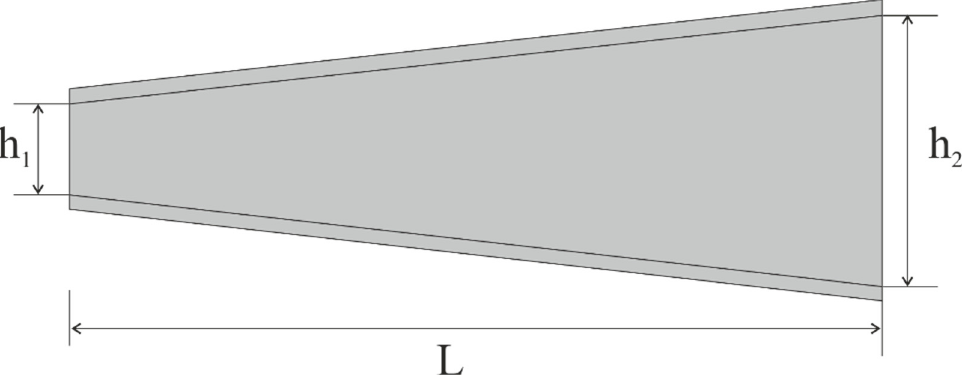
Figure 3. Top view of the beam used for numerical analysis.